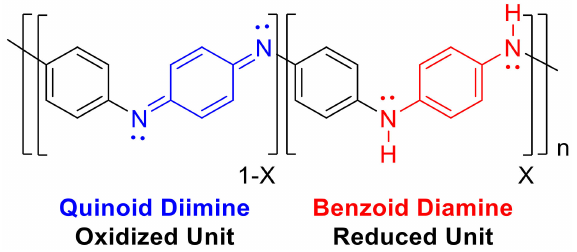
Figure 11. Oxidized and reduced